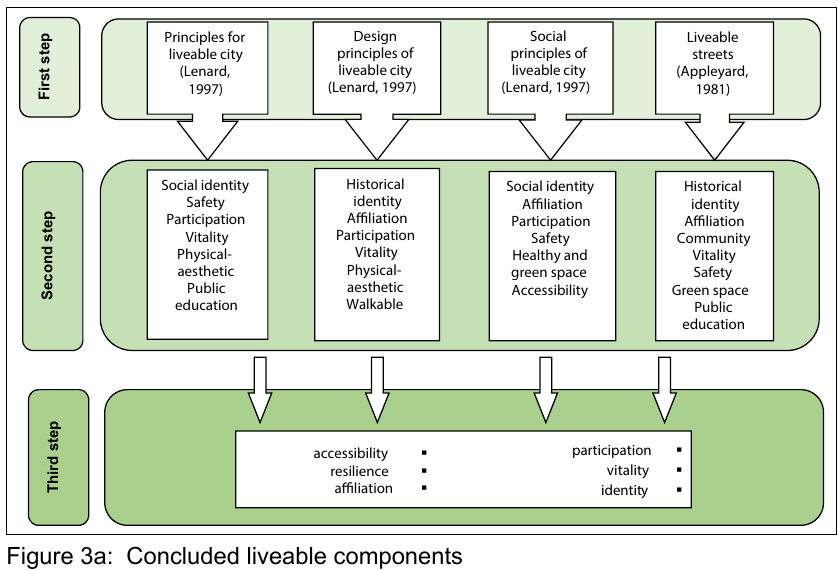
Figure 3a: Concluded liveable components Source: Researchers